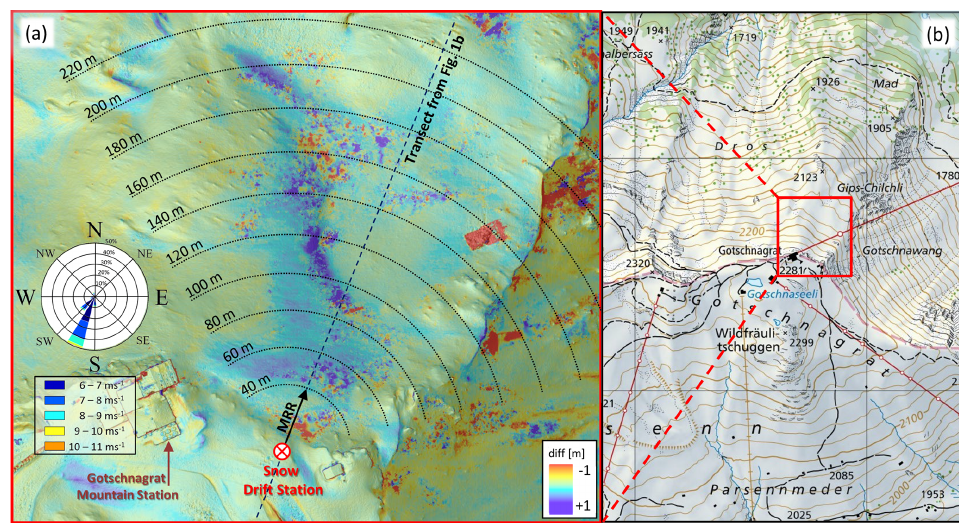
Figure 2. Aerial view of the study domain close to the Gotschnagrat mountain station: (a) colours indicate the difference in snow height (diff) between 29 and 12 March 2019 determined from two photogrammetry drone flights, showing areas of up to 1m of snow accumulation north of the snow drift station. The horizontally aligned MRR instrument is mounted at an azimuth angle of 22 ◦ at a height of about 1m above ground. A wind rose indicates the wind speed and direction of all major wind events with a wind speed > 6ms − 1 and thus potentially blowing snow effective for the period from 12:00UTC + 1 on 12 March 2019 to 12:00UTC + 1 on 21 March 2019. (b) Surrounding topography of the study site (Pixmap © 2020 swisstopo (5704000000), reproduced with permission of swisstopo (JA100118)).